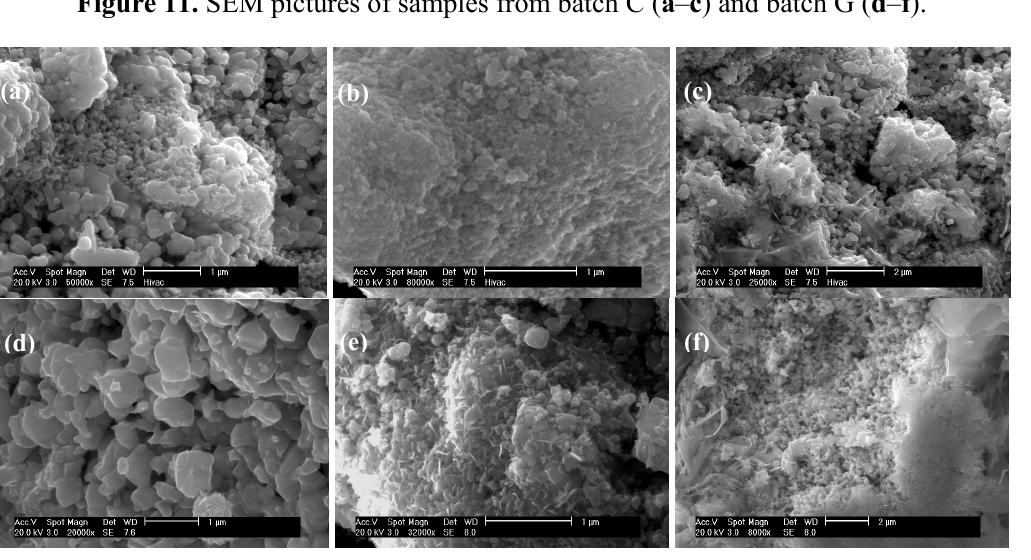
Figure 11. SEM pictures of samples from batch C ( a – c ) and batch G ( d – f